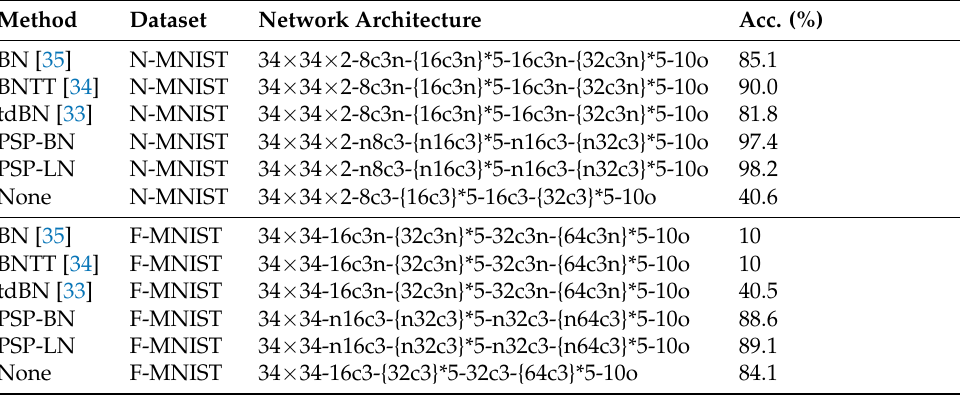
Table 2. Accuracies of N-MNIST and F-MNIST obtained from different methods. PSP-BN and PSP-LN are our normalization methods, and None is the model without normalization. Here, “c”, “n”, and “o” represent the convolution, normalization, and output neurons, respectively. In addition, each layer and spatial dimension in the network are separated by “-” and “ ×